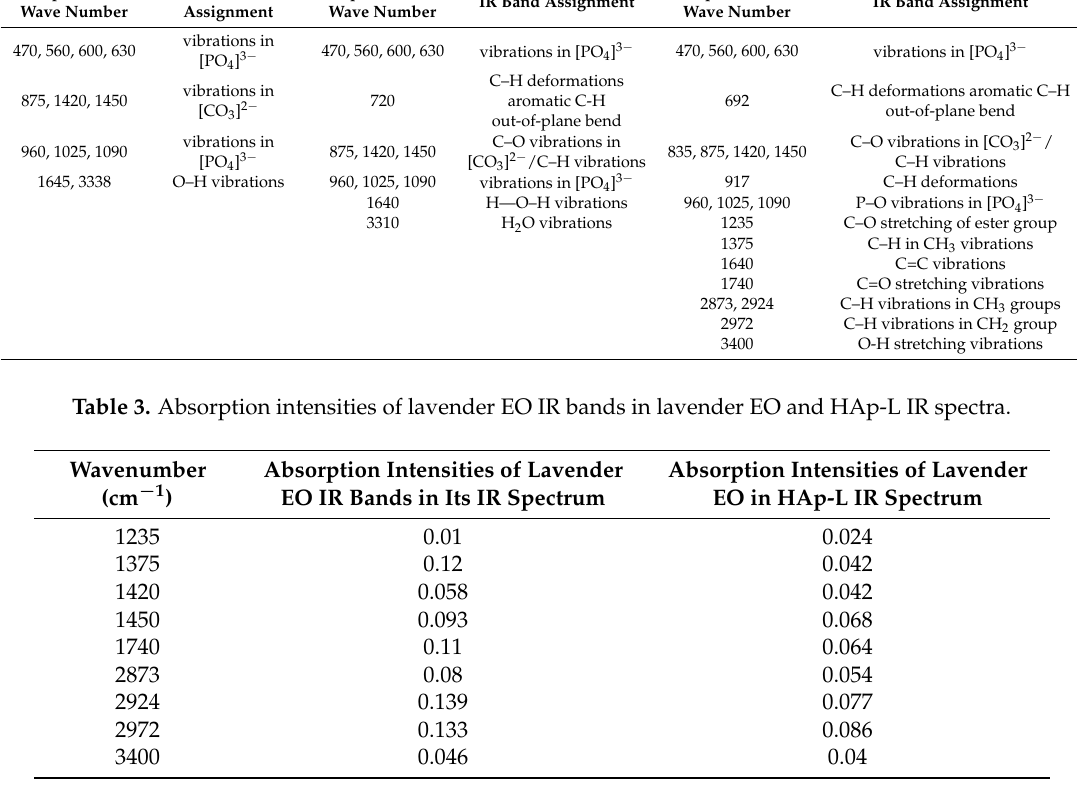
Table 2. The FTIR bands associated to the vibrational groups present in the HAp, HAp-B, HAp-L samples. HApIR Band Wave Number